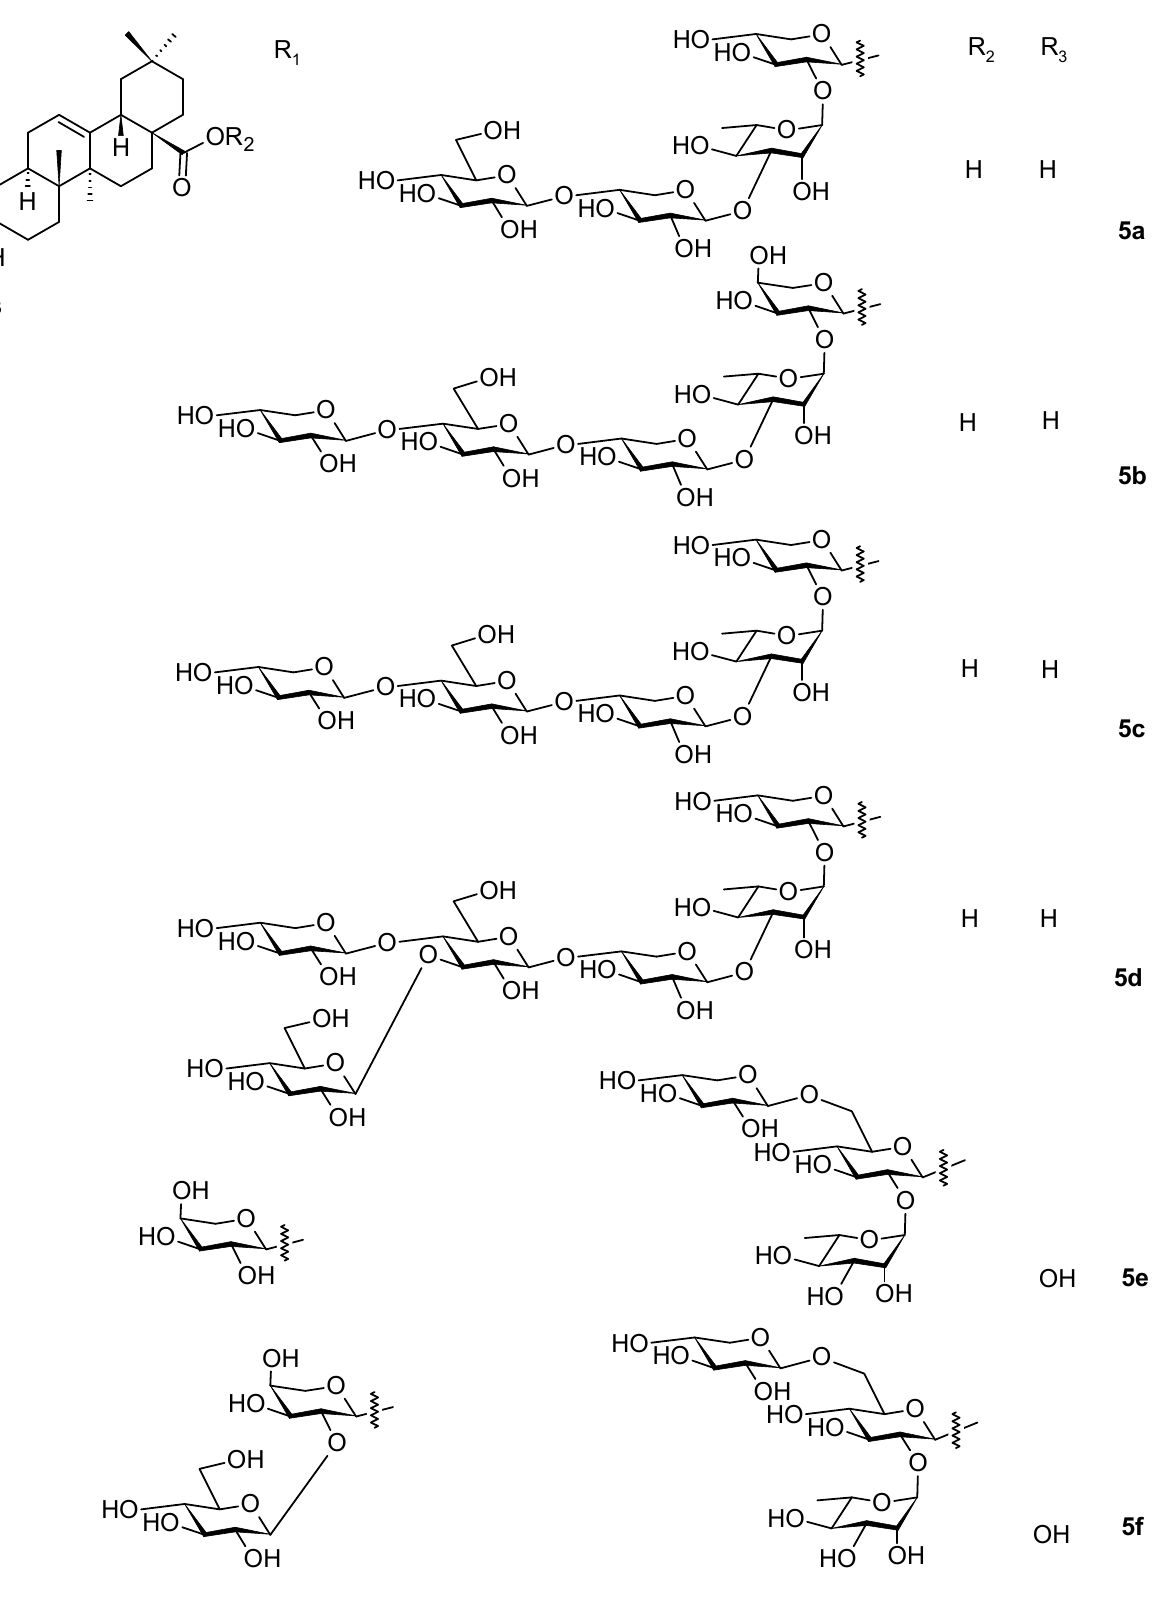
Figure 5. Oleanane-type triterpenoids found in the plants of the genus Weigela (part 3). A series of 13 so far undescribed triterpenoid saponins, named monellosides A-M ( 6a – 6m ; Figure 6), were isolated from the aerial parts of Anagallis monelli ssp. linifolia (L.)